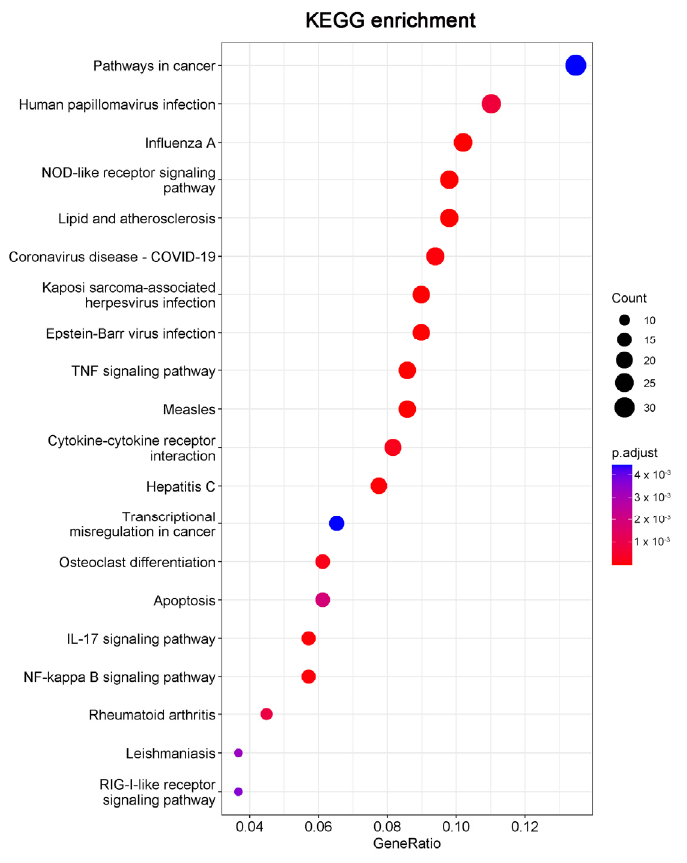
Figure 5. The top 20 pathways in the KEGG pathway enrichment analysis of the DEGs in 20(S)-GRh2-treated HeLa cells are shown in bubble plots. DEGs, differentially expressed genes; KEGG, Kyoto Encyclopedia of Genes and Genomes; 20(S)-GRh2, 20(S)-ginsenoside Rh2. Table 1. DEGs in apoptosis pathways.